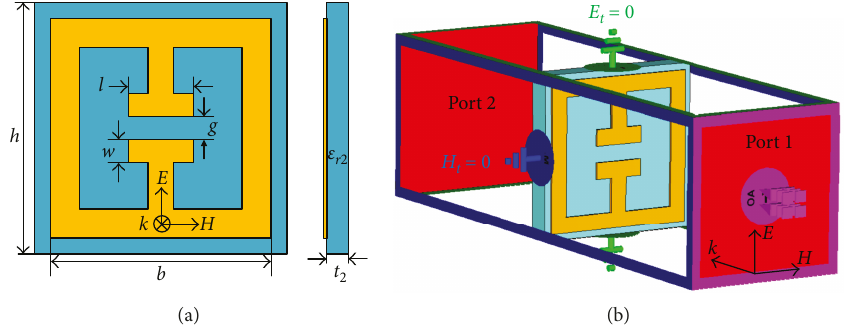
Figure 2: (a) Con fi guration of the square ELC resonator and (b) boundary conditions and polarization of an incident